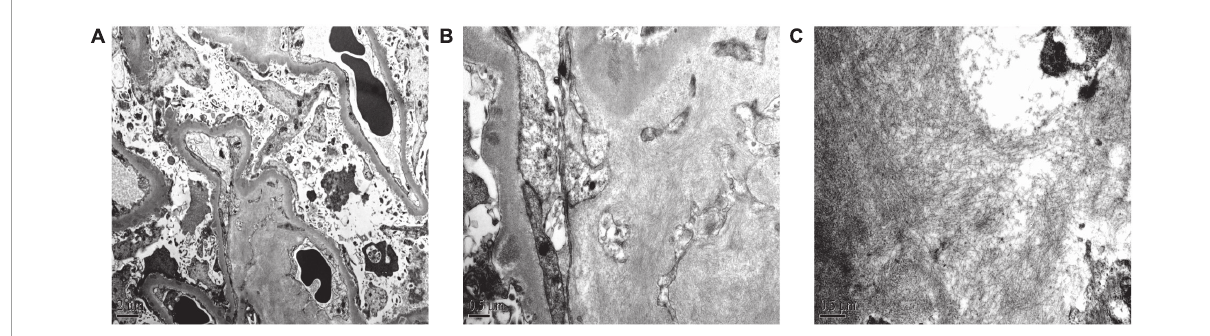
FIGURE3 Renal pathological features of electron microscopy. (A) Massive electron dense deposition in the subepithelial and basement membranes, and extensive fusion of epithelial podocytes (electron microscopy, 6,000 × ). (B,C) Scattered fibrous deposits in the mesangial region, basement membrane, and interstitium of the kidney (electron microscopy, 25,000 × and 30,000 × ,